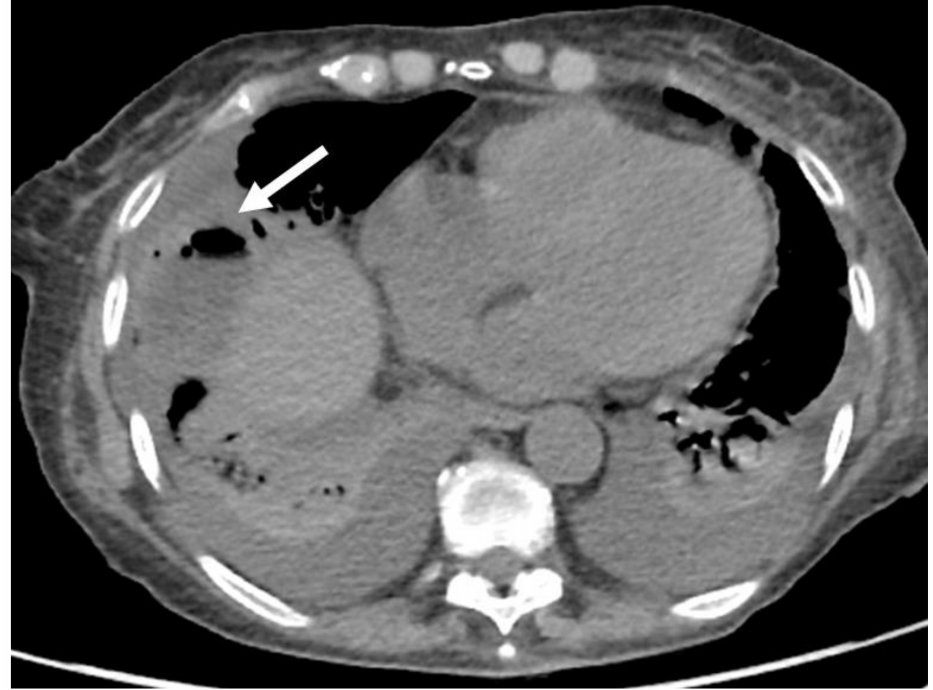
Figure 3. CT assessment at 1-week follow-up after radio frequency of HCC located on segment VIII. The arrow shows pulmonary abscess in patient with diaphragm damage.